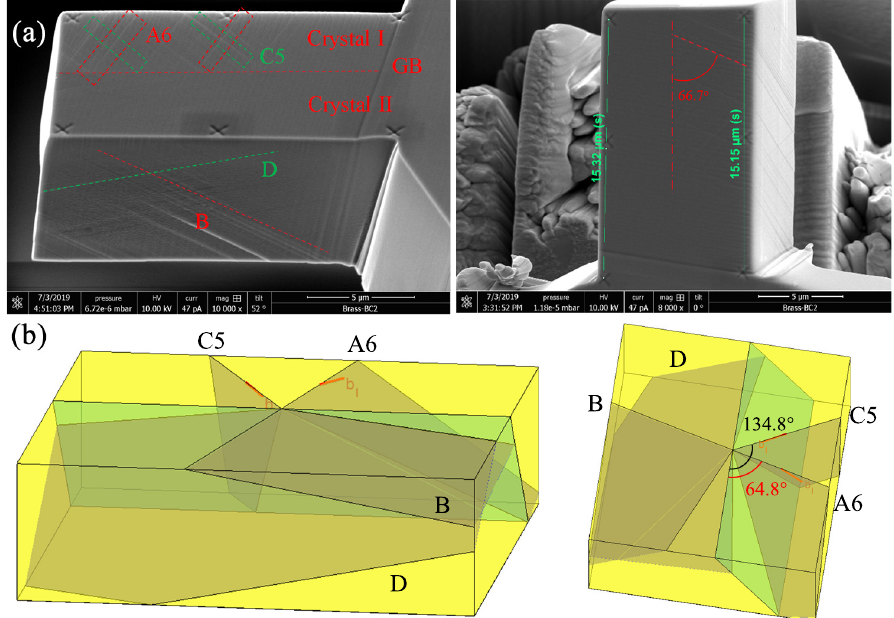
Figure 4. ( a ) crystallographic analysis of slip lines from SEM picture for the α -Brass sample; ( b ) theoretical analysis of slip systems based on microstructural data (see Table